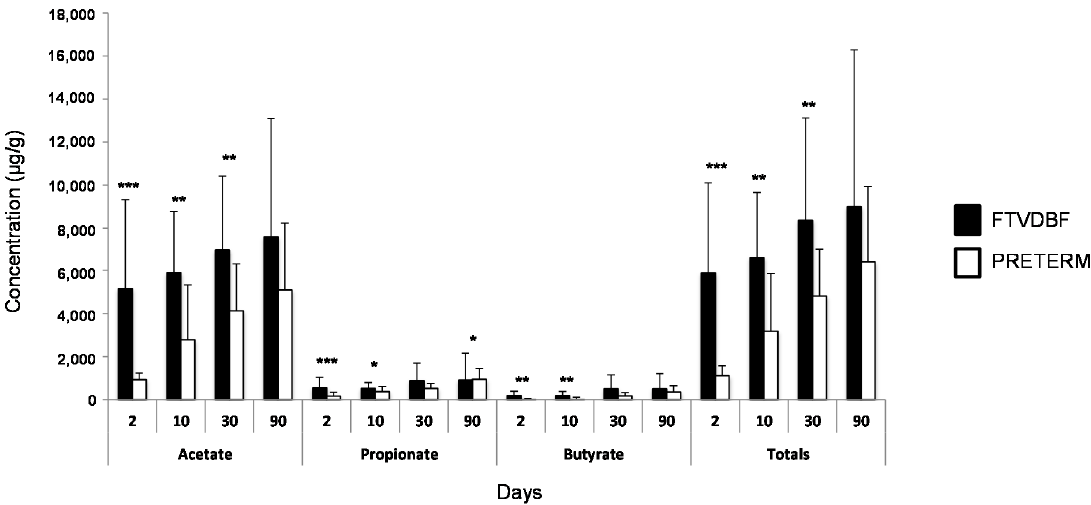
Figure 2. Concentration (mean ± SD) of the main SCFAs (acetate, propionate, and butyrate) and total SCFAs in fecal samples from full-term, vaginally delivered, exclusively breast-fed (FTVDBF) vs. preterm infants at the different time points analyzed (2, 10, 30, and 90 days). Asterisks indicate statistically significant differences (* p < 0.05; ** p < 0.01, *** p < 0.001).